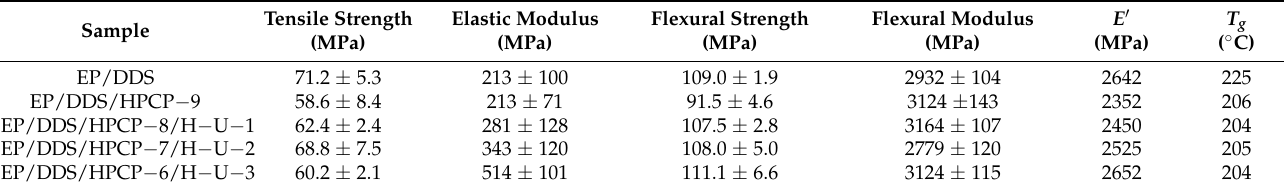
Table 3. Mechanical properties of EP